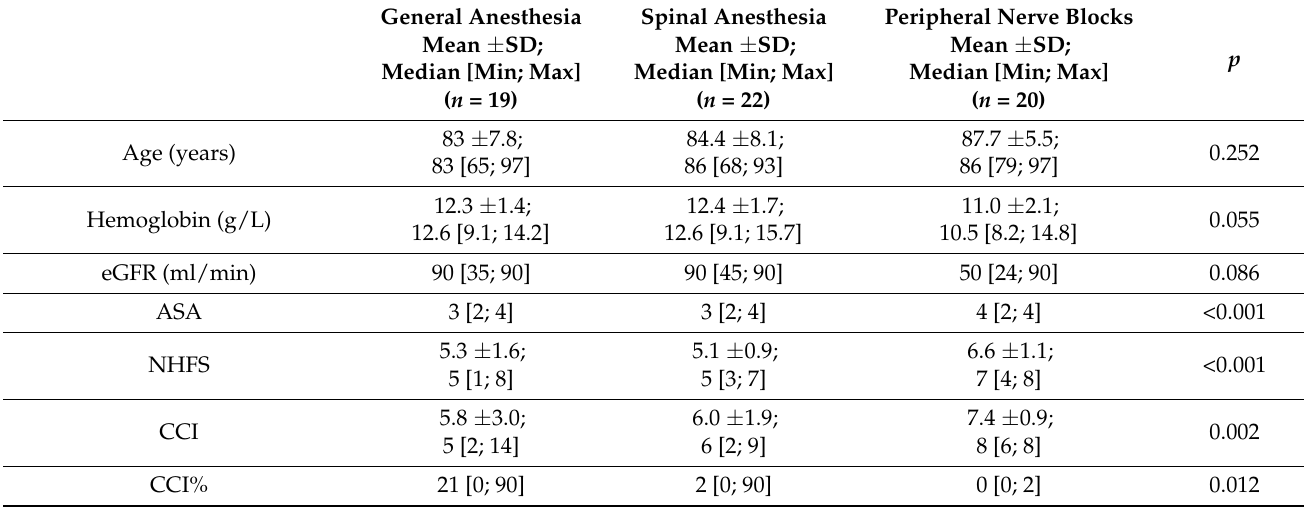
Table 2. Factors contributing to perioperative